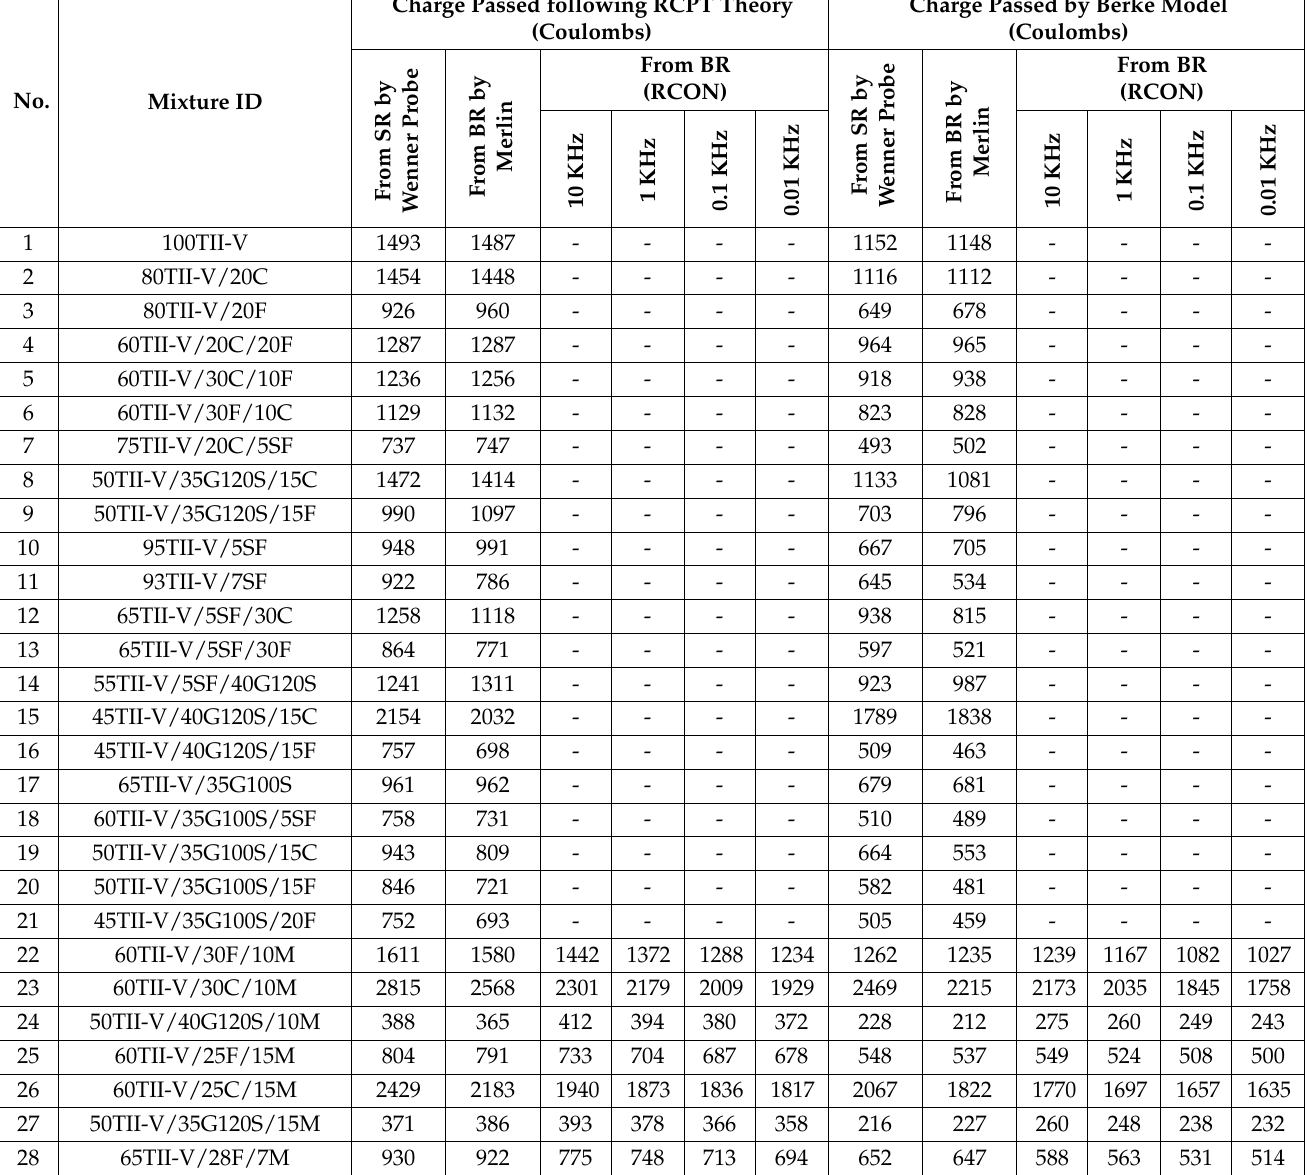
Table 2. Charge passed by two models from three different instruments at 91